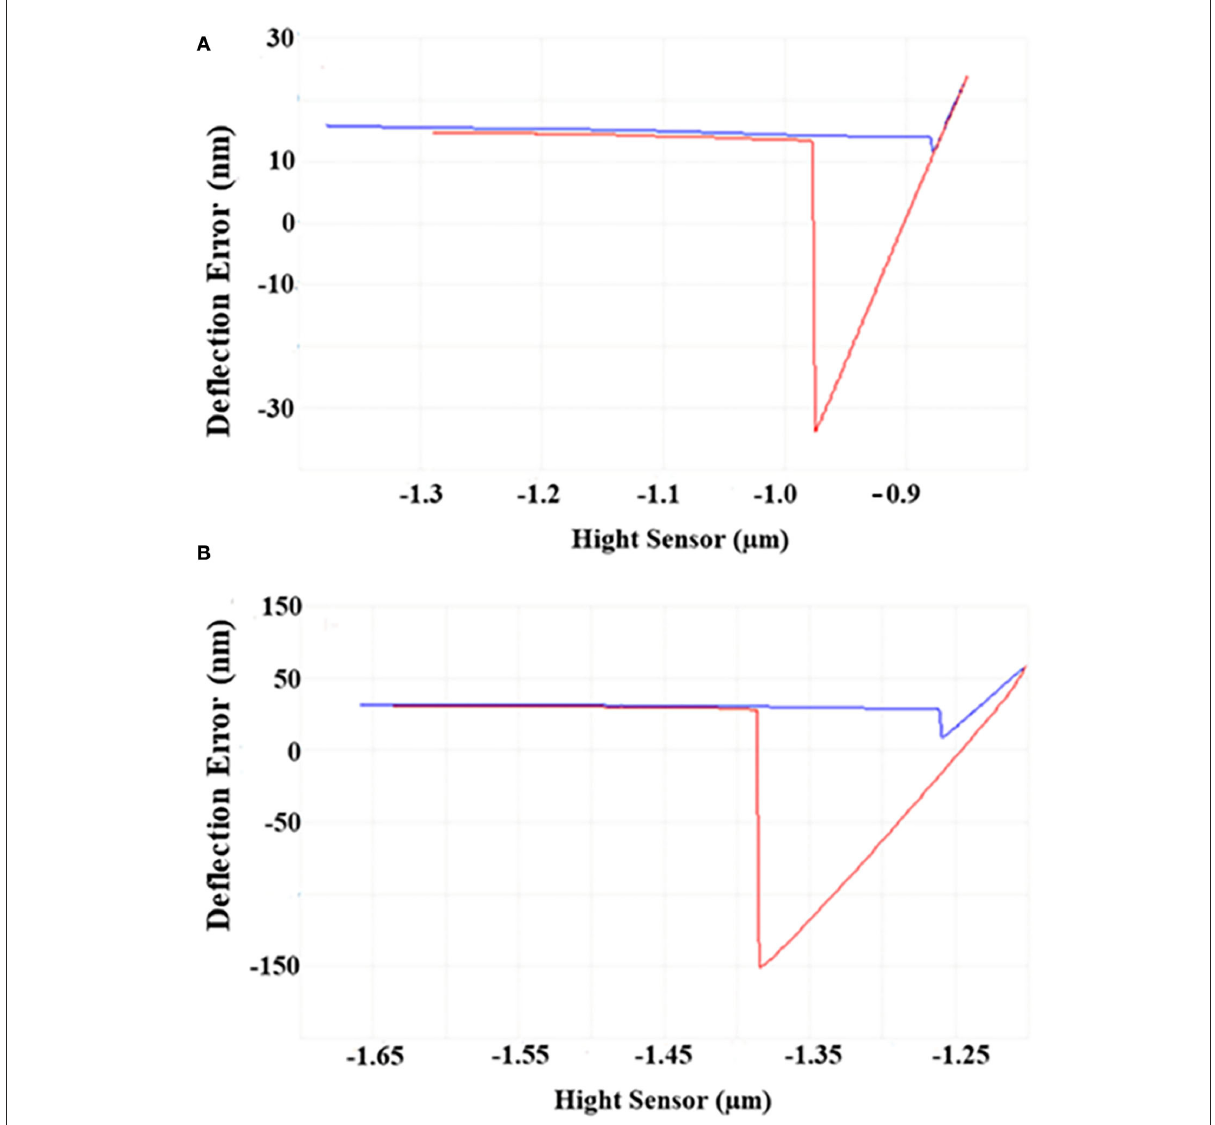
FIGURE2 AFM images of S. putrefaciens WS13. (A) AFM image of S. putrefaciens WS13 under 30 ◦ C. (B) AFM image of S. putrefaciens WS13 under 4 ◦